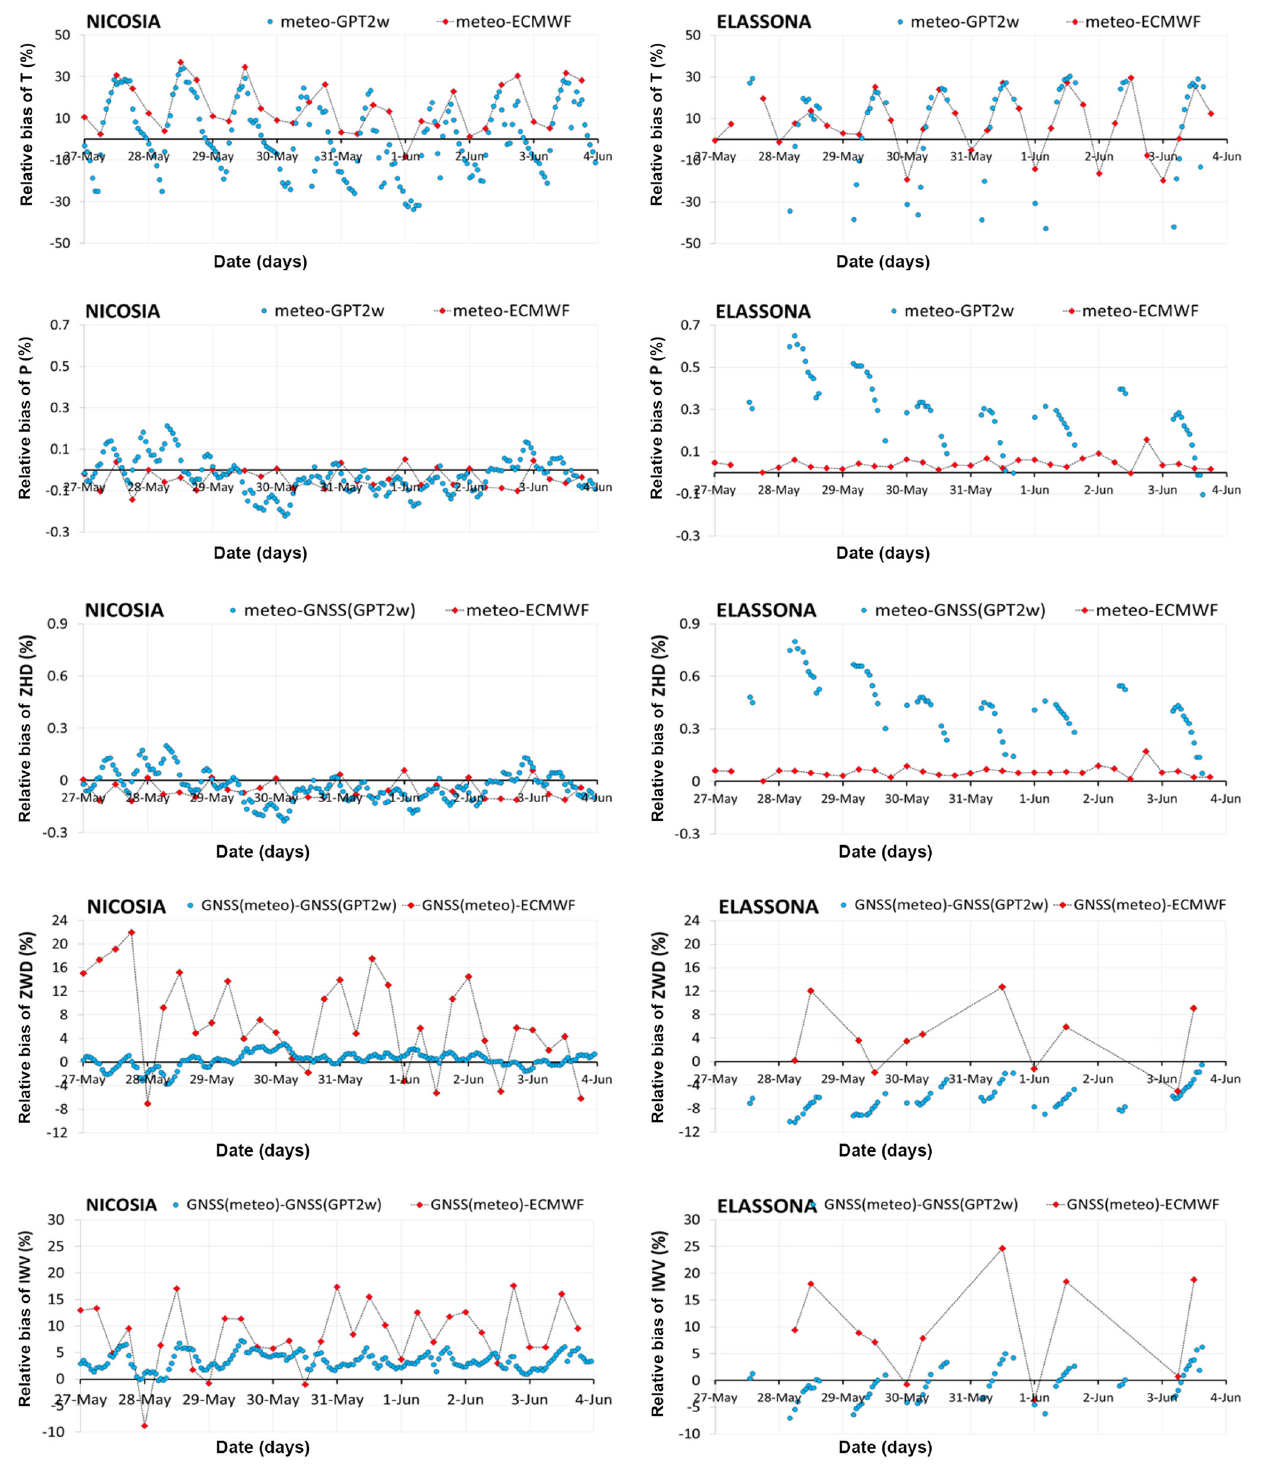
Figure 4. Same as Fig. 3 but for relative